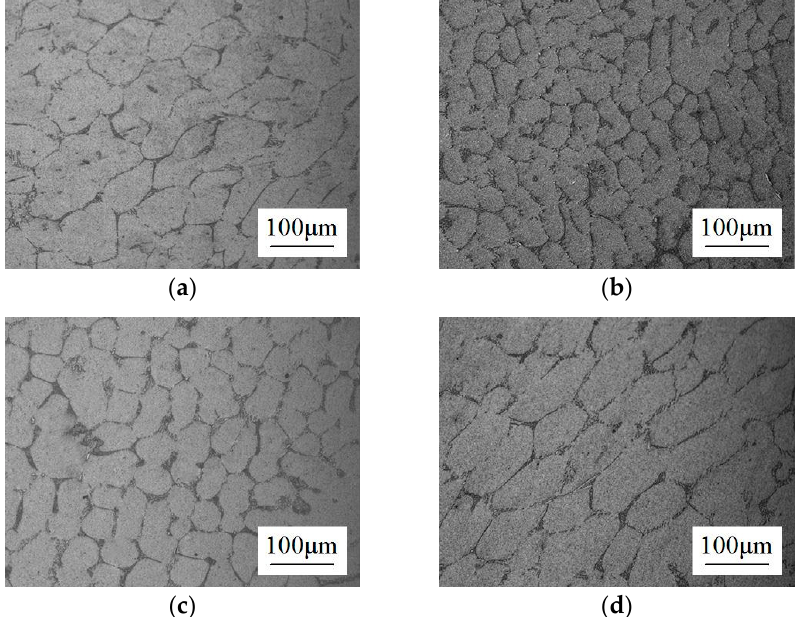
Figure 2. Microstructure of the solders: ( a ) SAC105; ( b ) SAC105-nano Fe 2 O 3 (20 nm); ( c ) SAC105-nano Fe 2 O 3 (50 nm); ( d ) SAC105-nano Fe 2 O 3 (200 nm) [28].